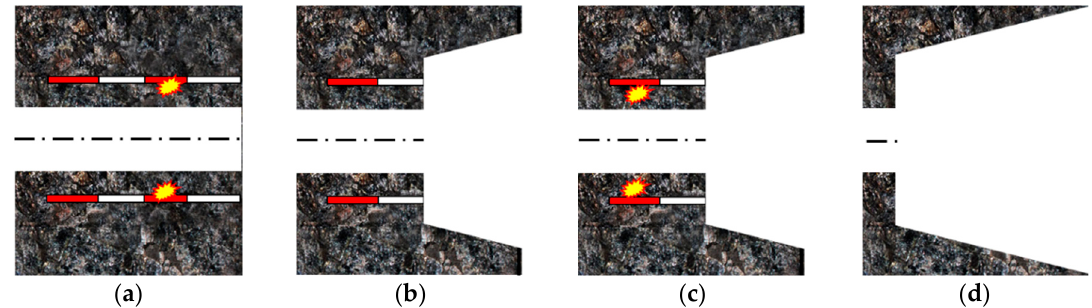
Figure 9. Expected rock fragmentation process of the proposed modified LLB method: ( a ) stage 1, ( b ) stage 2, ( c ) stage 3, ( d ) stage 4.